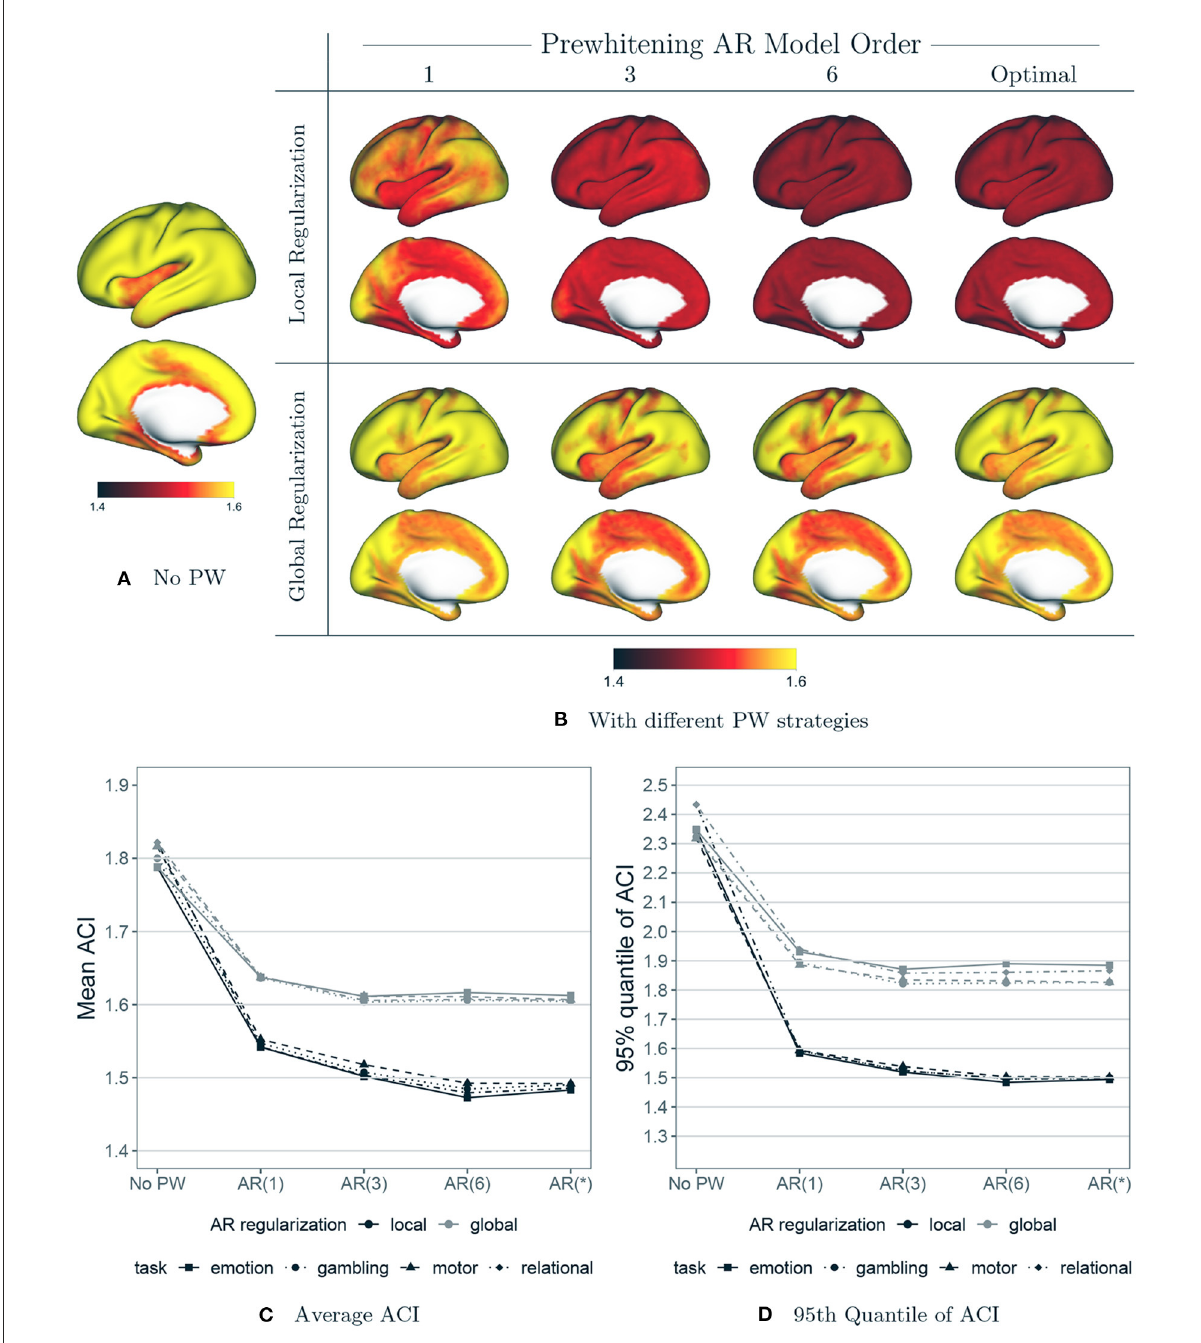
FIGURE9 The effect of prewhitening on autocorrelation index (ACI). (A) Mean ACI over all subjects, sessions and tasks before prewhitening. (B) Mean ACI after prewhitening. Eight different prewhitening strategies are shown, based on four different AR model orders (1, 3, 6 and optimal at each vertex) and two different regularization strategies for AR model coefficients (local smoothing vs. global averaging). Higher AR model order and allowing AR model coefficients to vary spatially results in substantially greater reduction in ACI. (C) Mean ACI over subjects and sessions, averaged across all vertices, by task and prewhitening method. Notably, allowing AR model coefficients to spatially vary reduces ACI much more than increasing AR model order. (D) 95th Quantile of